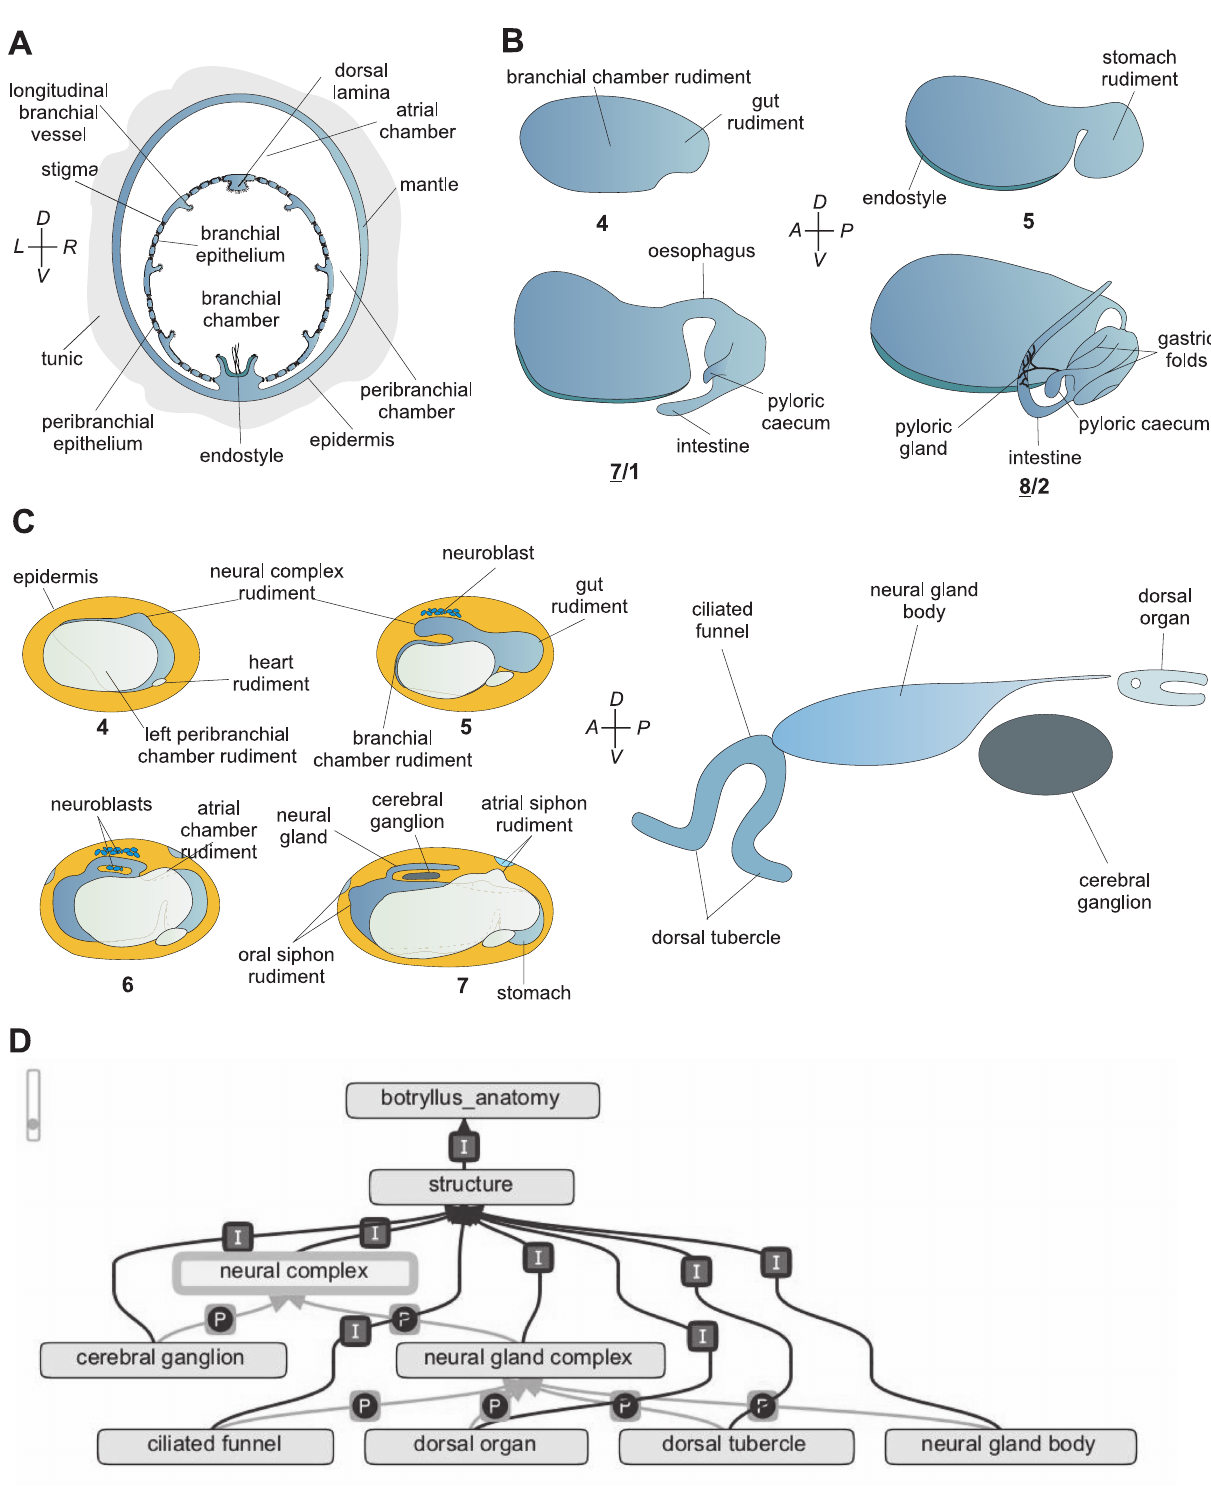
Figure 7. Schematised details of B.schlosseri blastogenesis and the relation to BODA. A . Schematic cross section of an adult blastozooid of B. schlosseri at the branchial chamber level (modified from [75]). B . Scheme of gut development in B. schlosseri bud (lateral view, anterior on the left). Each sketch shows the forming branchial chamber and the gut elongating posteriorly. Peribranchial chambers, epidermis and other organ rudiments are omitted for clarity. Stages of development are indicated below each sketch: upper sketches refer to secondary buds (stages 4 and 5), bottom sketches to primary buds (stages 7/1 and 8/2). Modified from [49]. C . Scheme of main morphogenetic events of neural complex development. Left: lateral view; anterior on the left; bud stages indicated by numbers. Right: scheme of the adult neural complex (modified from [47]). D . Graph generated by the OBO-edit editor indicating anatomical entities referring to neural complex anatomy in BODA.